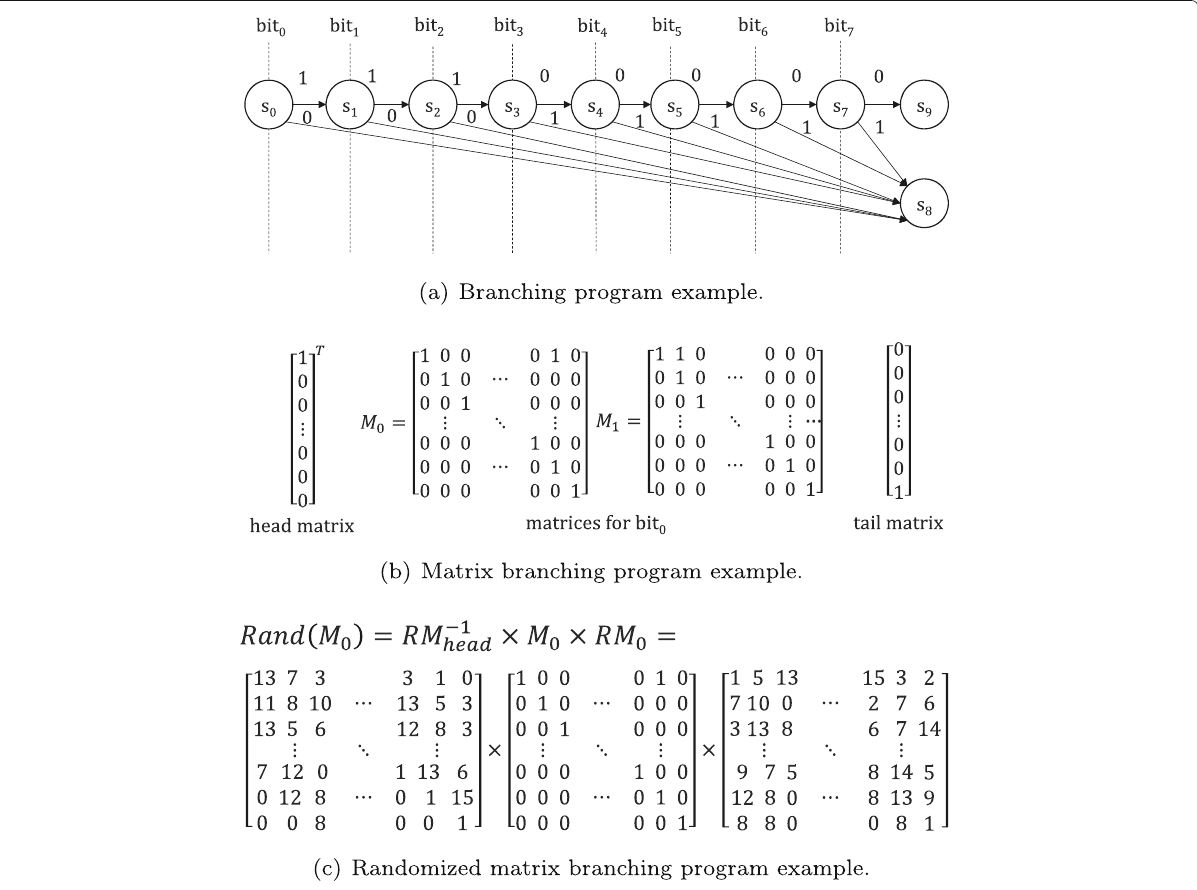
Fig. 10 The procedures to convert a program (i.e., if x of int8 equals to 7) to a randomized matrix branching program